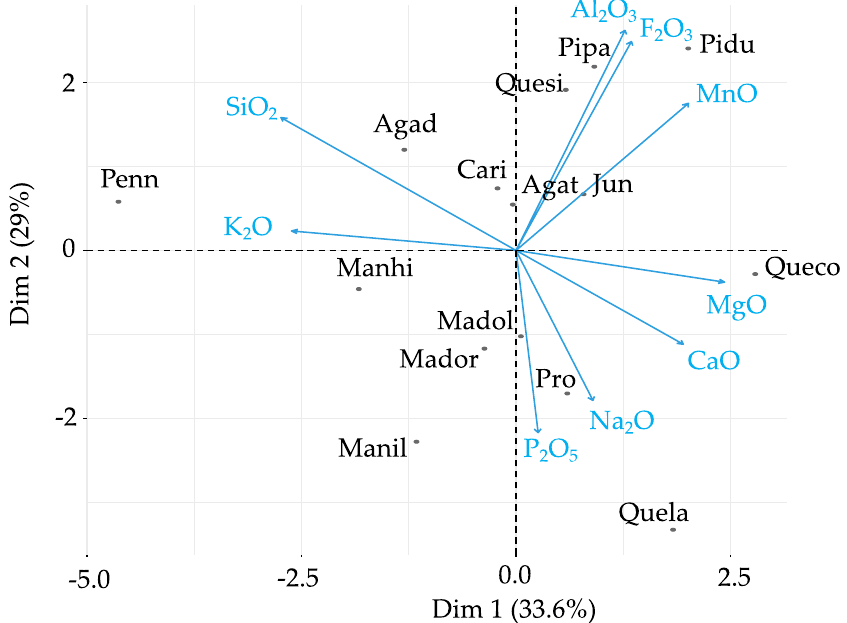
Figure 5. Principal components analysis at 1000 ◦ C. Blue lines show the vectors in the CP1 and CP2, the points represent the pellets sources